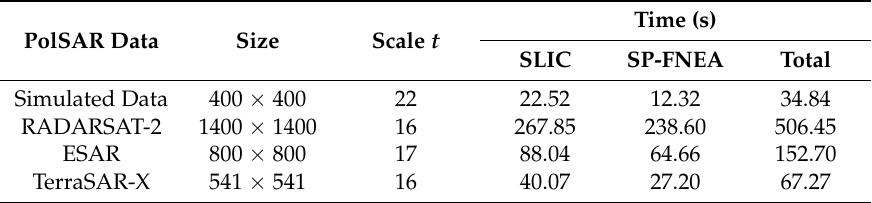
Table 5. Runtimes of the proposed algorithm for different PolSAR